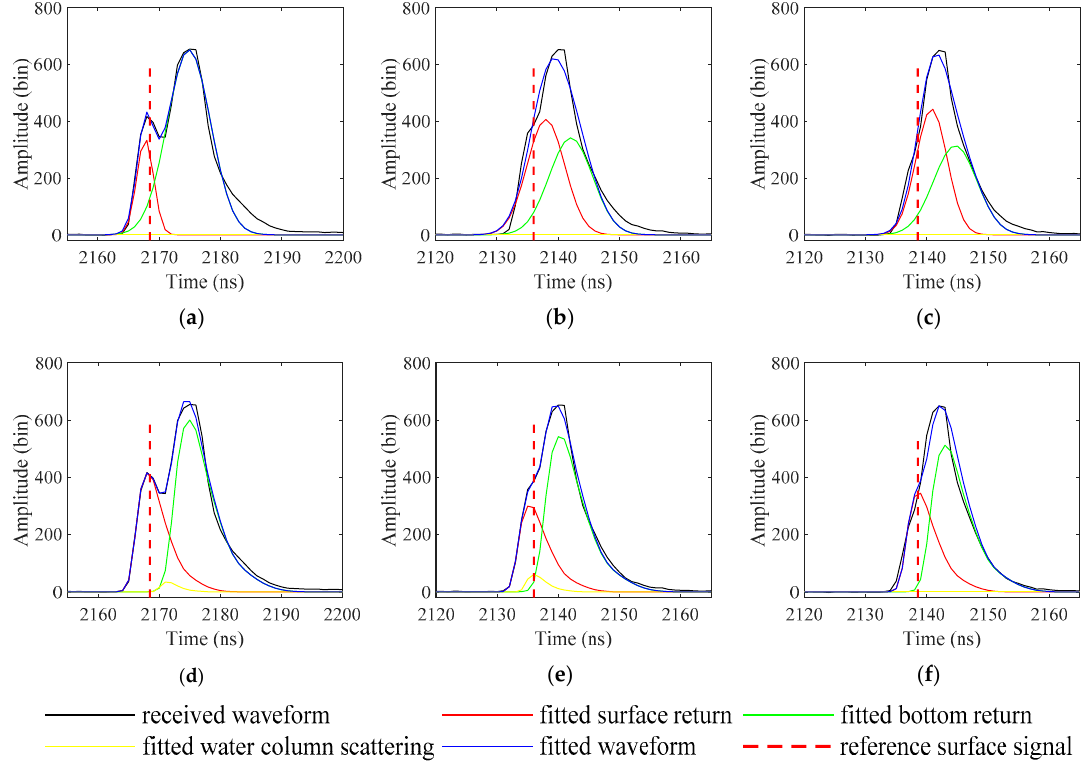
Figure 17. Waveforms fitted with ( a – c ) the Gaussian model and ( d – f ) the EW model.